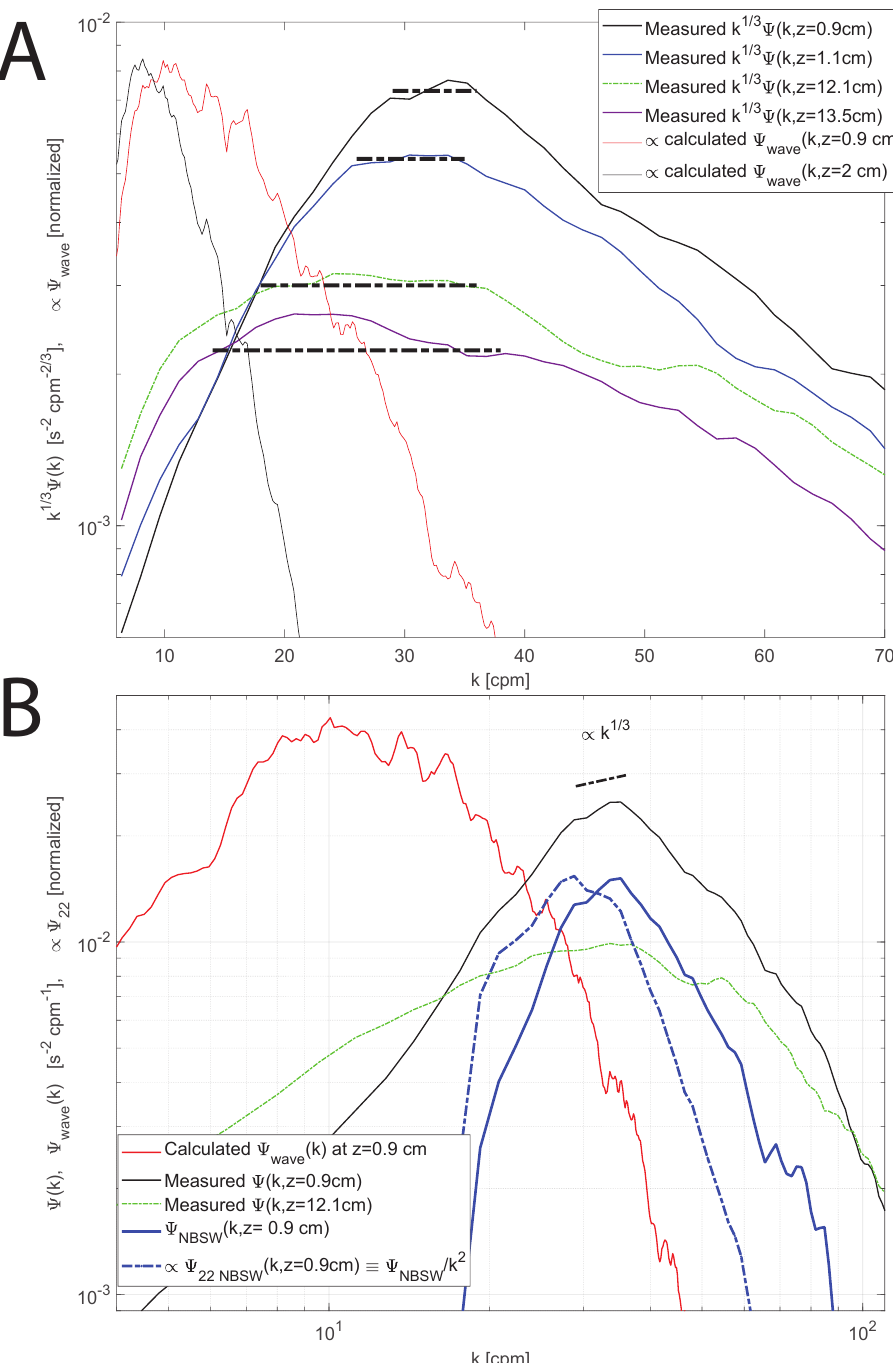
Figure 2. ( A ) Measured compensated shear spectra, k 1/3 Ψ ( k , z ) for the case U curr = 0.125 m/s characterized by the NBSW with a dominant wave length of 8 cm. The shear spectra are com- pared to normalized Ψ wave ( k , z ) , obtained from the Equation (10) at depths 0.9 and 2 cm and at the x 0 location. The horizontal dashed lines represent approximate extent of the inertial sub- range. ( B ) Black line: the measured shear spectrum Ψ ( k , z = 0.9 cm ) at depth z = 0.9 cm compared with calculated Ψ wave ( k , z = 0.9 cm ) —corresponding to the red line. The continuous blue line: the Ψ ( k , z = 0.9 cm ) . The blue dashed line: the velocity spectrum: Ψ ( k , z = 0.9 cm ) . The NBSW 22 NBSW black dashed line: the approximate extent of the inertial subrange of the Ψ NBSW ( k , z = 0.9 cm ) spec- trum. Note the peak in the Ψ 22 NBSW ( k , z = 0.9 cm ) at the beginning of its inertial subrange at around the wavenumber k NBSW = 30